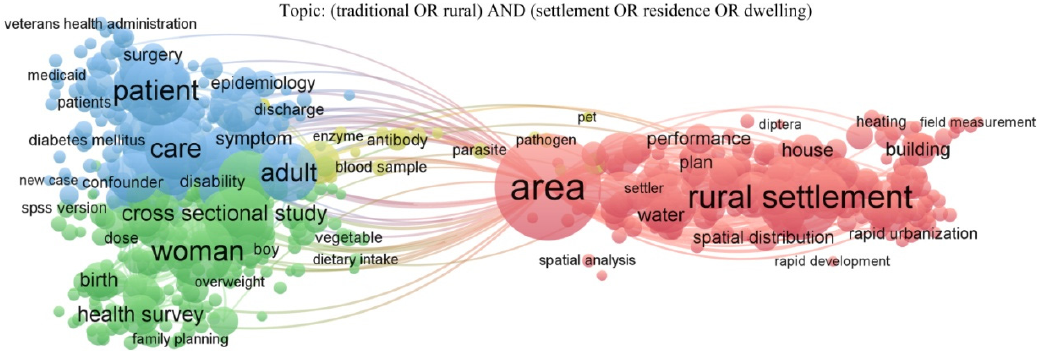
Figure 1. Analysis diagram of the literature on traditional or rural settlements in the past decade.